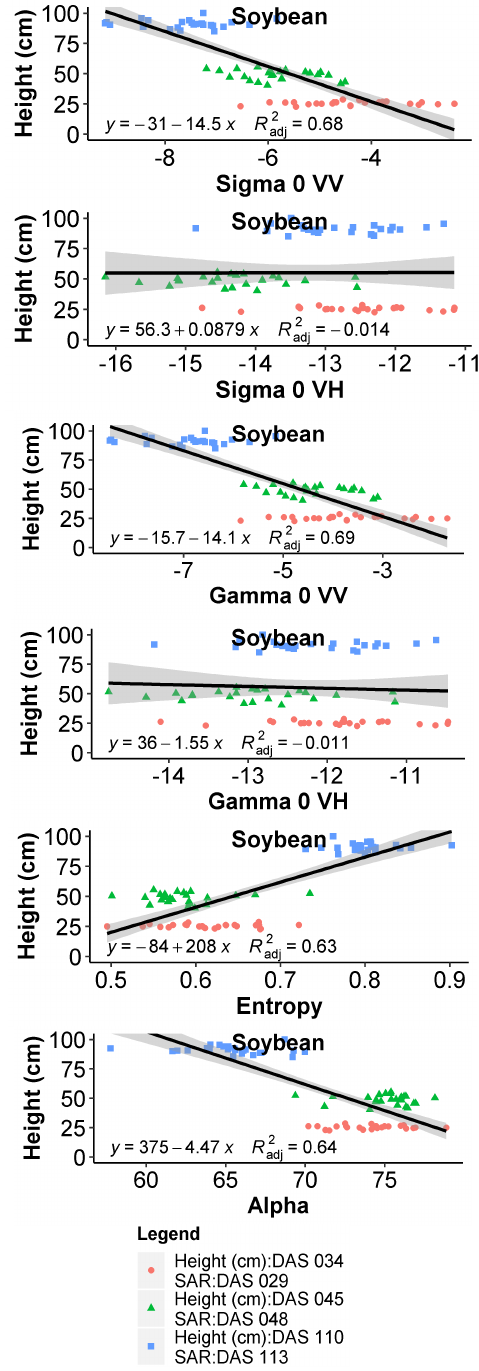
Figure 6. Relationship between Height and Sigma, Gamma, Entropy and Alpha angle for soybean. The scatter plots between height and SAR attributes for wheat (Figure 7) show directly relation among height and cross- polarizations backscattering and entropy. Moreover, there are inversely relation among wheat height and co-polarization backscattering and alpha. The differences among the relation showed in Figure 6 and 7 were the presence of relation between cross-polarization backscattering with the wheat height and the greater values of R 2 adj for entropy and alpha at wheat than at soybean